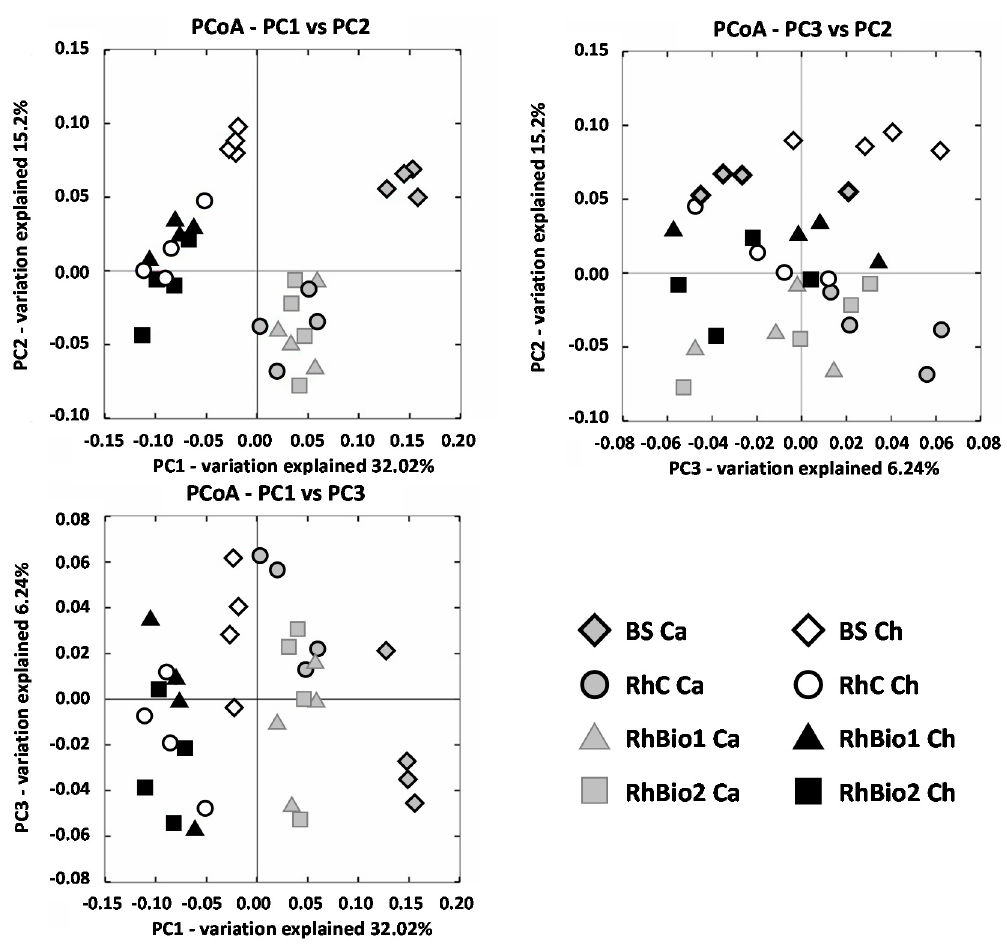
Figure 2. The Principal Coordinate Analysis (PCoA) of the bacterial communities in the different soil samples analysed. Percentages shown along the axes represent the proportions of dissimilarity captured by the axes. Each symbol represents the 16S rRNA gene sequences from each sample, which are depicted in a scale of grays, using a shape for each soil condition (rhombus = bulk soil; circle = control rhizosphere, triangle=rhizosphere with Bio1; square=rhizosphere with Bio2). BS = bulk soil; RhC = rhizosphere of control plants; RhBio1 = rhizosphere of plants from seeds treated with Bio1; RhBio2 = rhizosphere of plants from seeds treated with Bio2; Ca = Carignano site; Ch = Chivasso